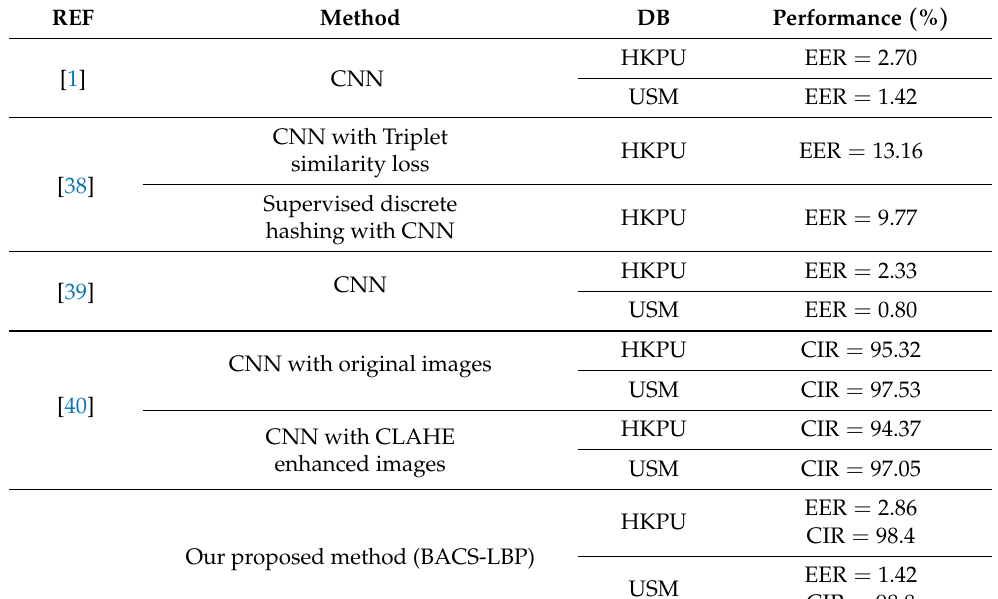
Table 7. Comparison between the proposed method and deep learning